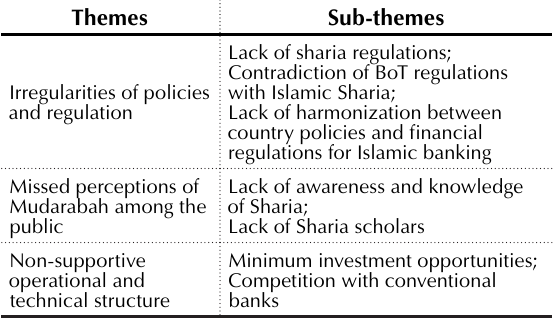
Table 2. Thematic findings from in-depth interviews with bank